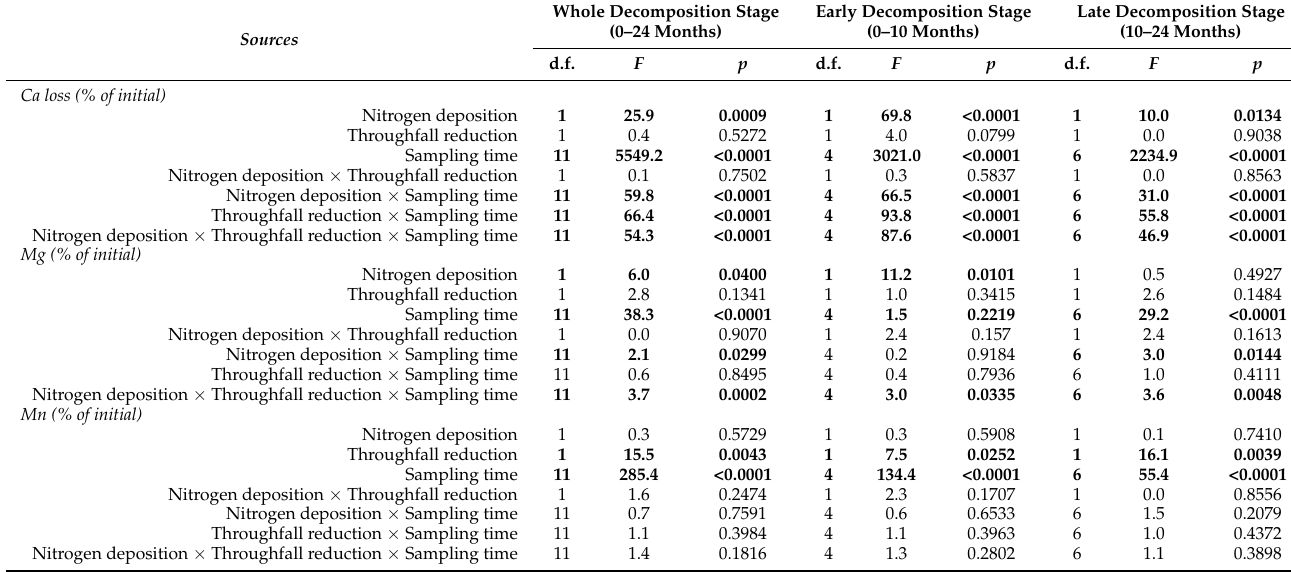
Table 2. F- and p- values of linear mixed effects models on the effects of nitrogen deposition, throughfall reduction, sampling time and their interactions on the loss of Ca, Mg, and Mn during different decomposition stages. Significant effects are given in